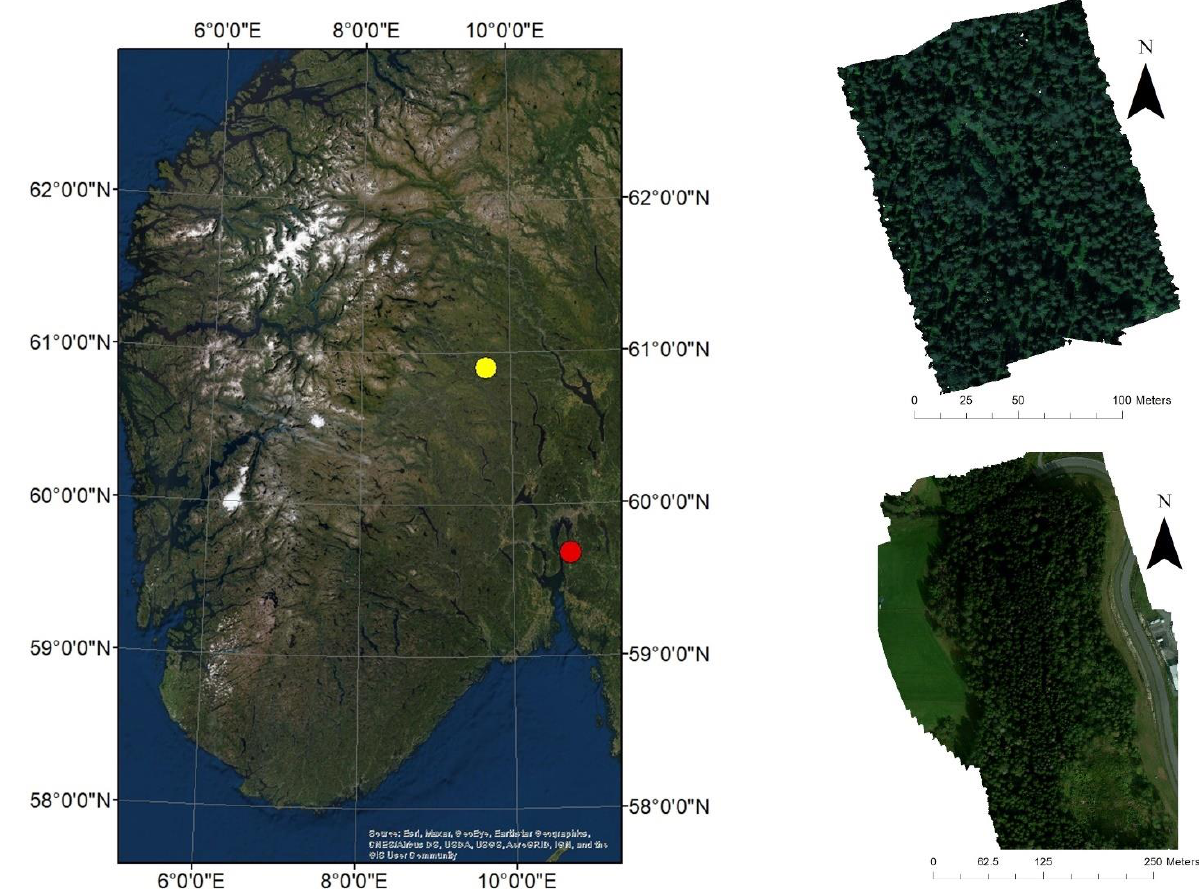
Figure 1. Location of study areas in southern Norway ( left ): Etnedal (yellow) and Nordskogen (red). True color rendering of Etnedal imagery ( top right ) and Nordskogen ( bottom right ).